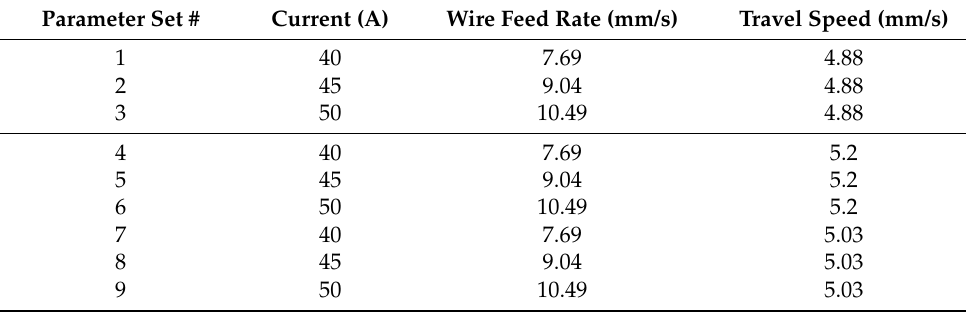
Table 3. Processing parameters for Inconel 718 single pass